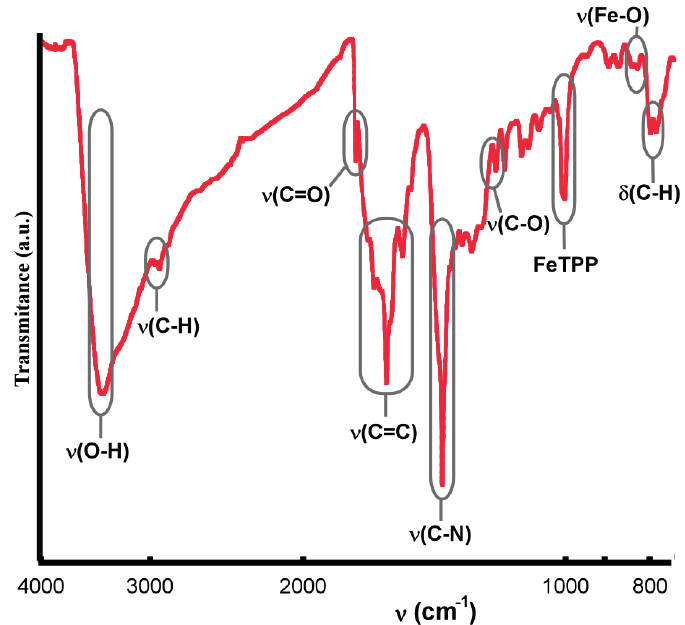
Figure 12. IR spectrum for compound 6